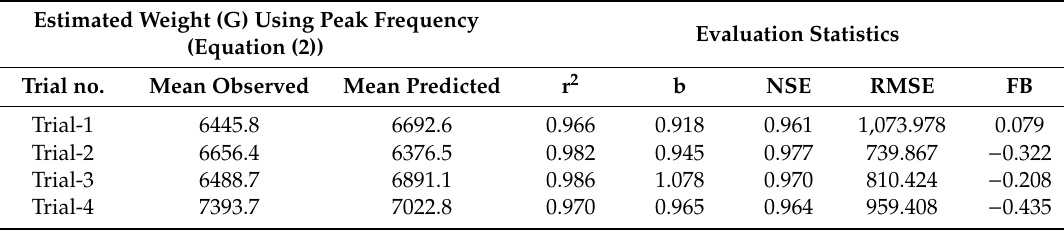
r 2 = coe ffi cient of determination, b = slope of regression line, NSE = Nash-Sutcli ff e e ffi ciency, RMSE = the root mean square error, FB = fractional